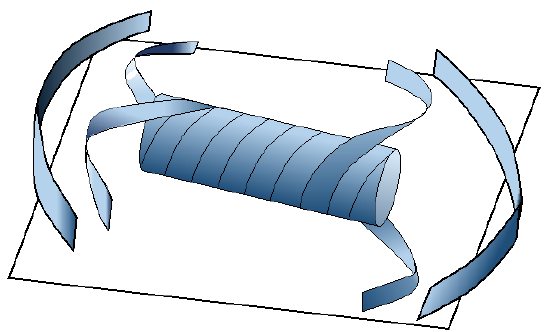
Figure 16. Taken from [21]. A stylized sketch of the proposed director field pattern when the mesophase region is extending outwards from a helically wound core. Note that the ribbons drawn in this figure are intended to give a three-dimensional impression of the alignment within the director field. They are not intended to imply that the striations are caused by ribbon-like fibrils.